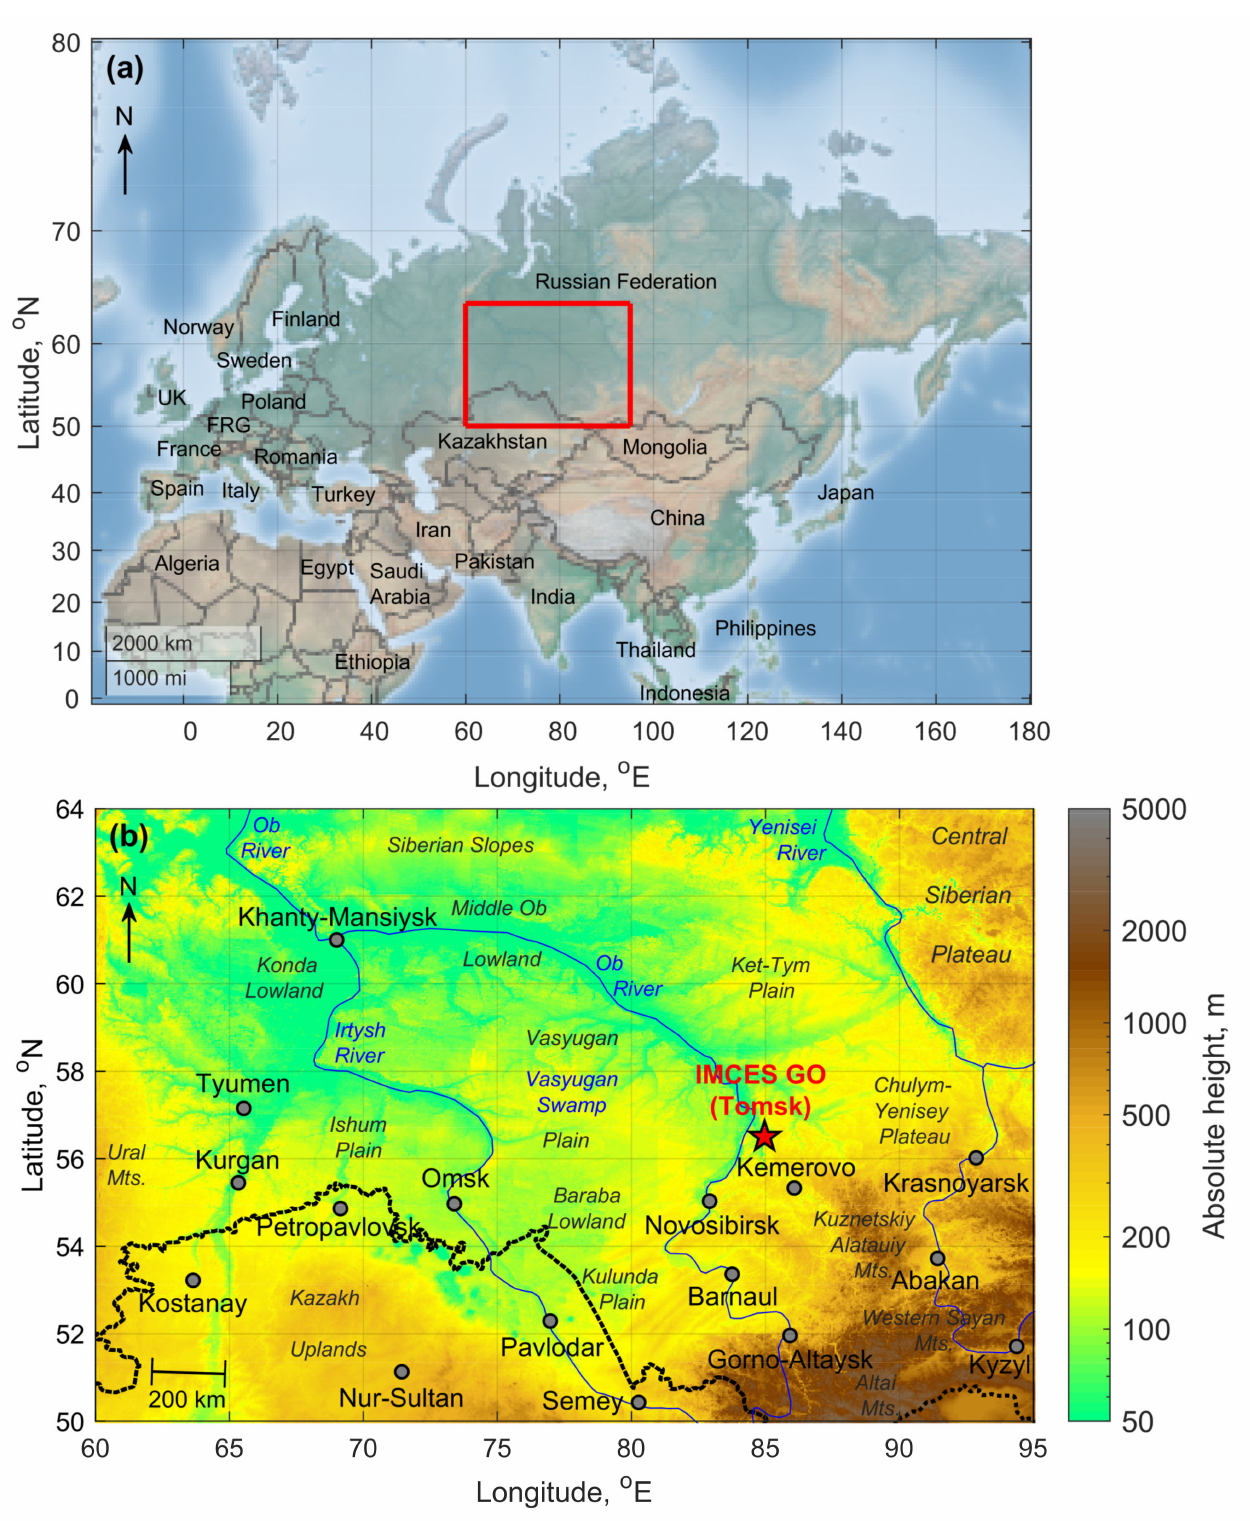
Figure 1. The region of studies ( a ) and the location of the IMCES GO ( b ). The map are shown based on the global digital elevation model ETOPO2